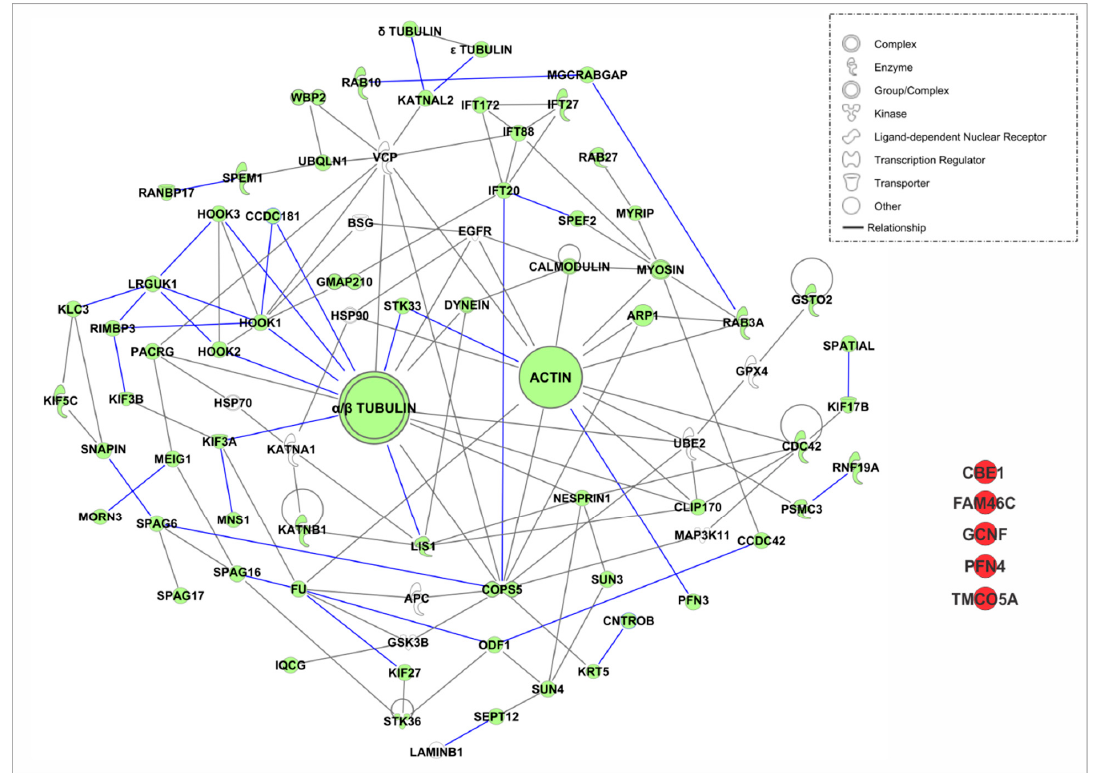
Figure 4 . Interactome of proteins involved in intramanchette transport. The Ingenuity Figure 4. Interactome of proteins involved in intramanchette transport. The Ingenuity Pathway Pathway Analysis (IPA), software from QIAGEN Inc., was used for protein interaction Analysis (IPA), software from QIAGEN Inc., was used for protein interaction analysis. Proteins known analysis. Proteins known to localize in the manchette were analyzed. Only proteins with to localize in the manchette were analyzed. Only proteins with validated protein–protein binding validated protein–protein binding were included in the analysis. The tool “Path Explorer” were included in the analysis. The tool “Path Explorer” in the IPA software was used to generate in the IPA software was used to generate the interactome. Gray lines are interactions found the interactome. Gray lines are interactions found by the software in IPA databases. Blue lines by the software in IPA databases. Blue lines indicate known interaction validated from indicate known interaction validated from current literature by IP, co-IP, yeast two-hybrid screen, current literature by IP, co-IP, yeast two-hybrid screen, tubulin-binding assay, and affinity tubulin-binding assay, and a ffi nity column purification. Species were limited to human, mouse, and column purification. Species were limited to human, mouse, and rat.